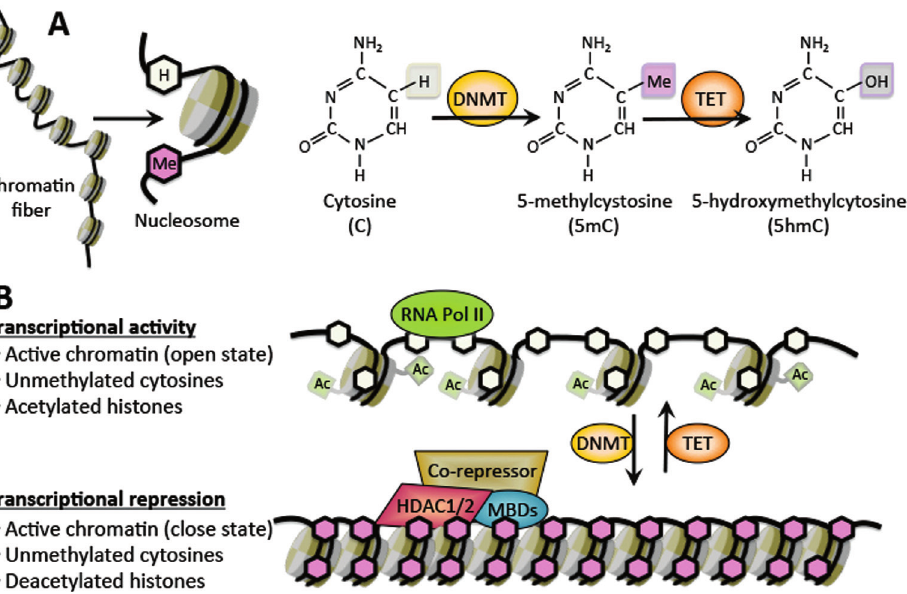
Figure 1: Basic principles of DNA methylation as an epigenetic mechanism. (A) The DNA fiber is coiled twice around histone octamers, forming nucleosomes, which are the building blocks of a chromosome. The free nucleotide cytosine is incorporated into DNA during replication. DNA methylation occurs at 5-position of cytosine residues in an enzymatic reaction catalyzed by DNA methyltransferases (DNMTs). 5-Methylcystosine (5mC) can be further converted by TET1-3 enzymes to 5-hydroxy- methylcytosine (5hmC), leading to DNA demethylation. (B) Schematic of the reversible alterations in chromatin organization that influence gene expression: genes are transcribed when the chromatin is acetylated and active (open state), and they are transcriptionally repressed when the DNA is methylated and chromatin is condensed (close state). The complex MBDs-HDAC1/2, bound to methylated, double-stranded DNA, suppresses gene transcription and converts chromatin integrity into a condensed state. White hexagons, unmethylated cytosines; pink hexagons, methylated